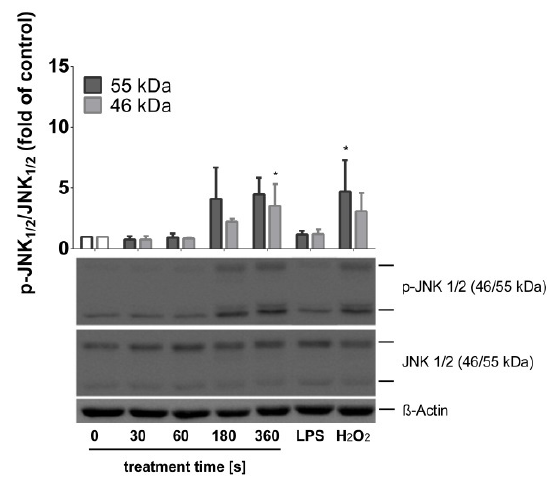
Figure 3 : Western blot analysis of the JNK pathway. Human monocytes were lysed after 3 h of plasma treatment. Subsequently, Western blot analysis was performed with the protein solution to determine the phosphorylated as well as the total level of the protein JNK 1/2 at 46 and 55 kDa. Relative phosphorylation level was calculated as a ratio of phosphorylated to total protein and plotted as bar diagrams. H (100 μM) and LPS (1 μg mL -1 ) treated samples served as controls for apoptotic and proliferative pathways. All samples were normalized to the untreated control (0 s). β-Actin (45 kDa) was used as a loading control. Data from three independent experiments are